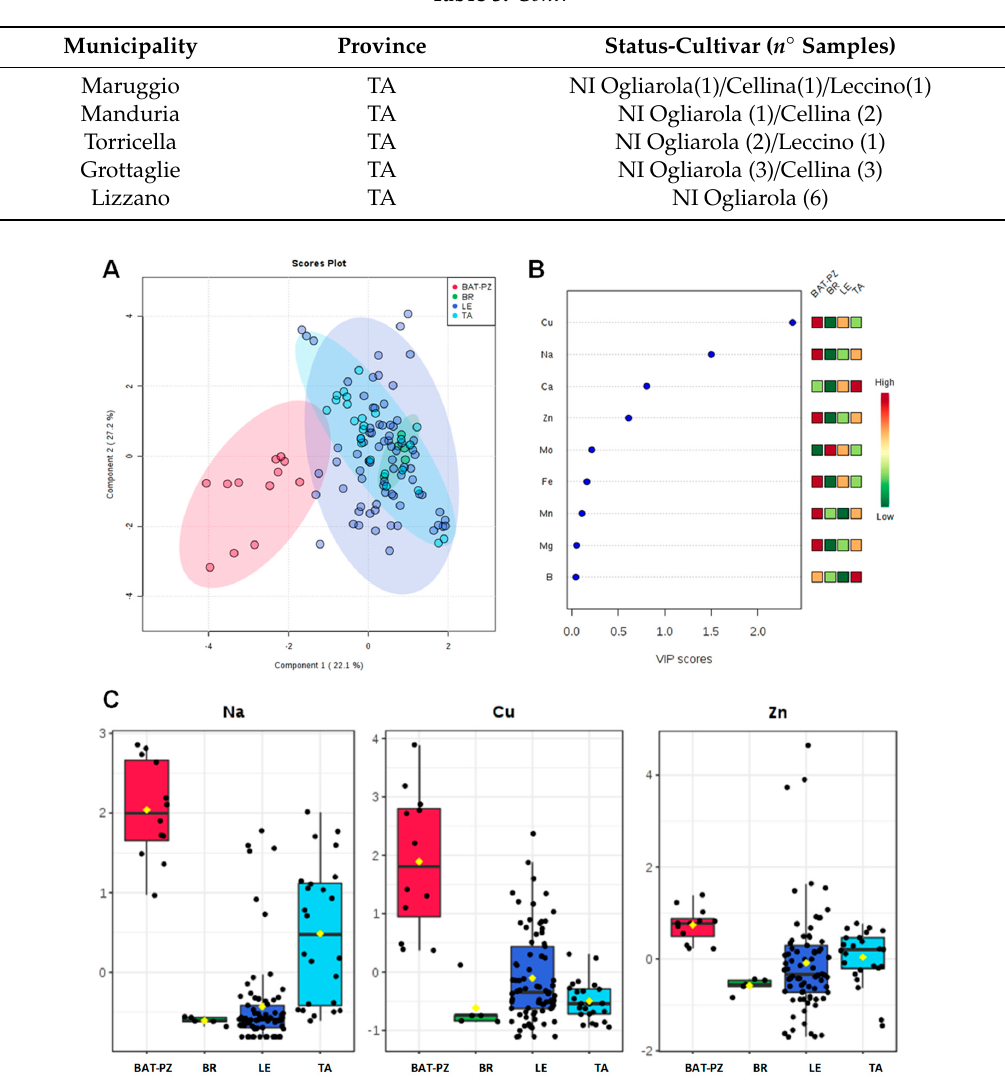
Figure 1. PLS-DA scoreplot ( A ), importance of variables ranked by VIP (Variable Importance in Projection score) ( B ) and box plot for the discriminant elements ( C ) obtained for soil samples, with a VIP score > 1. (Figure 1B: the colored boxes on the right indicate the relative increase/decrease of the corresponding variable in each group). BAT: Barletta-Andria-Trani; LE, BR, TA: Lecce, Brindisi, Taranto provinces (Apulia); PZ Potenza province (Basilicata, Apulia bordering region).